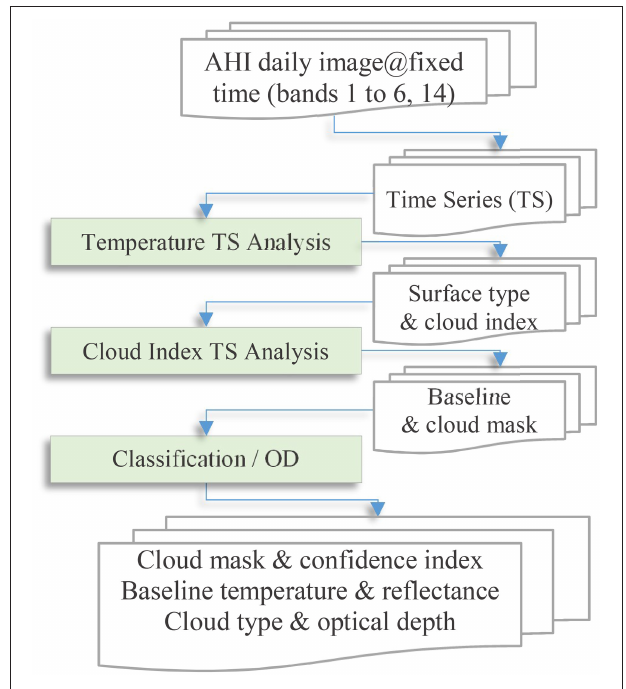
FIGURE 1 | Work-flow for cloud masking based on time-series (TS) analyses, and cloud classification and optical depth (OD) retrieval using radiative transfer